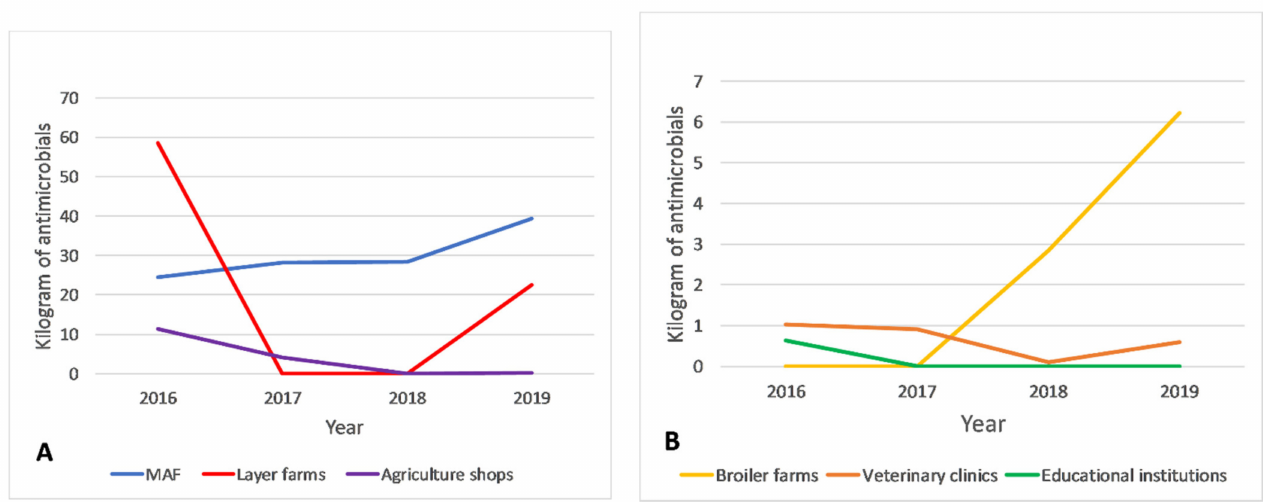
Figure 4. ( A , B ): Trend of antimicrobials imported by different importers between 2016 and 2019. Bigger importers are represented in ( B ) and smaller importers in ( B ), thus y -axes differ between